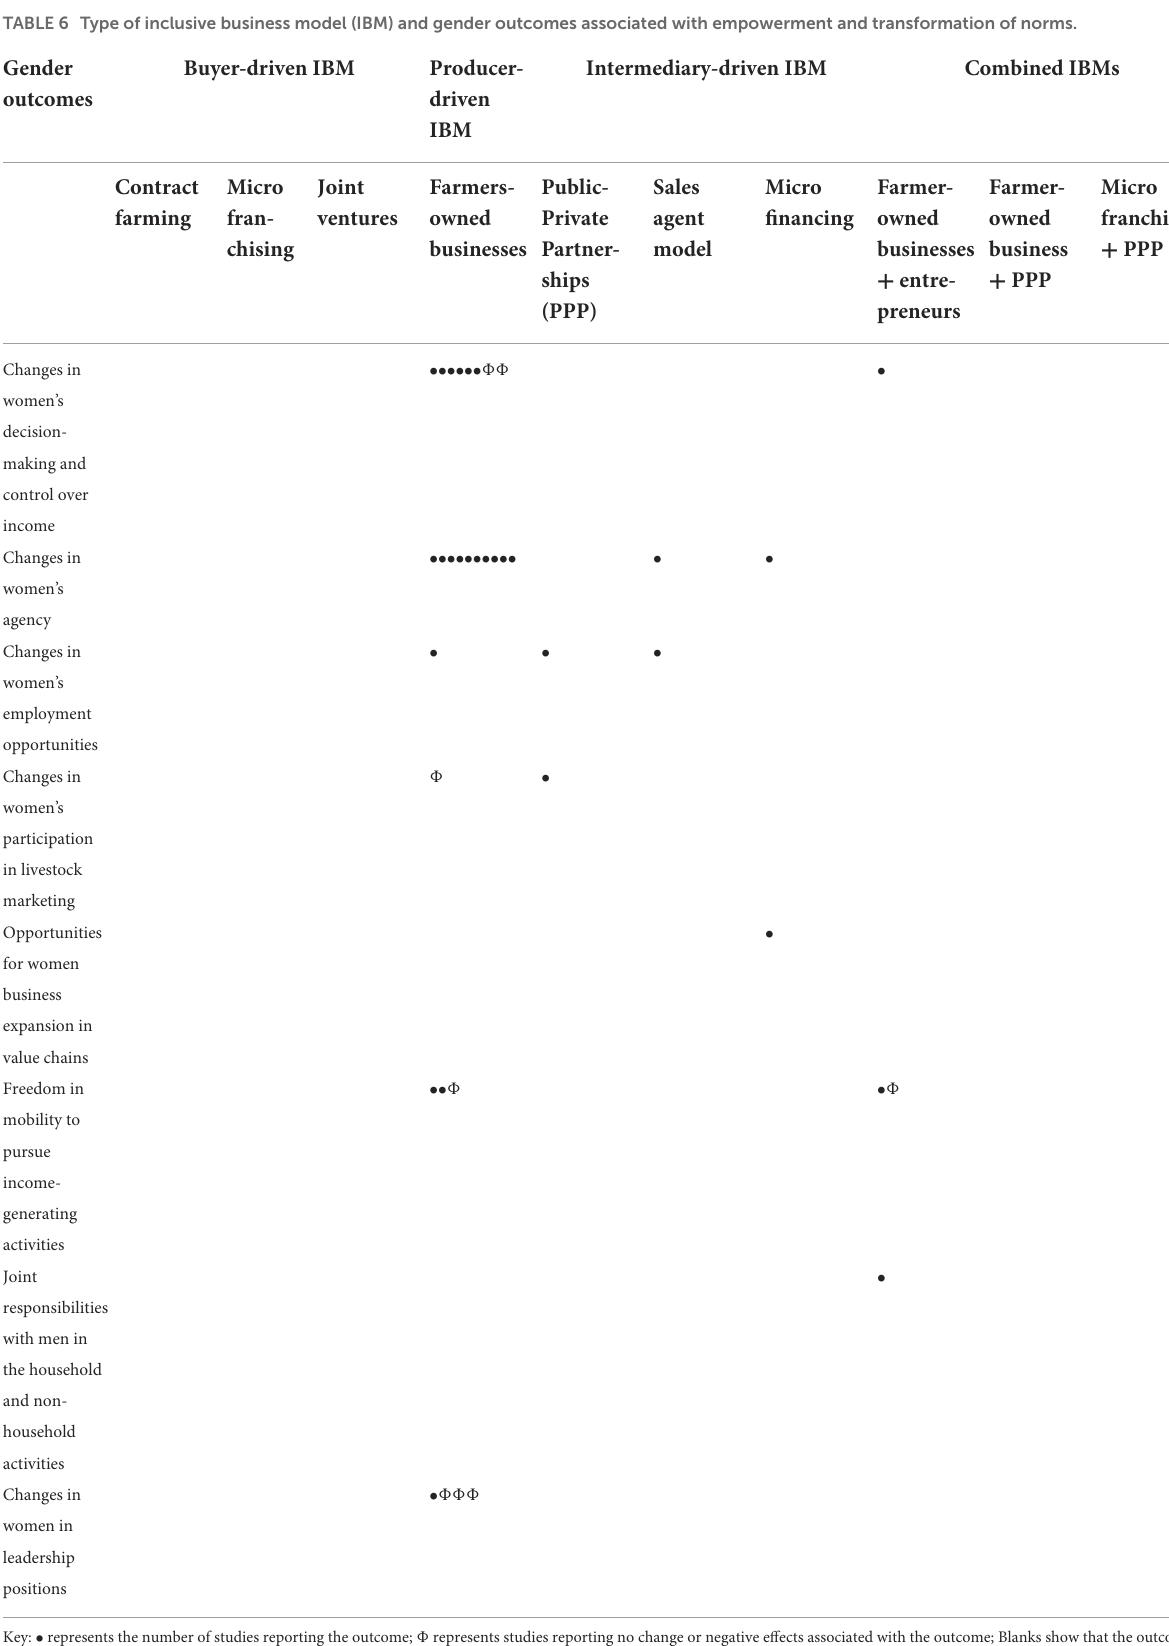
TABLE 6 Type of inclusive business model (IBM) and gender outcomes associated with empowerment and transformation of norms.